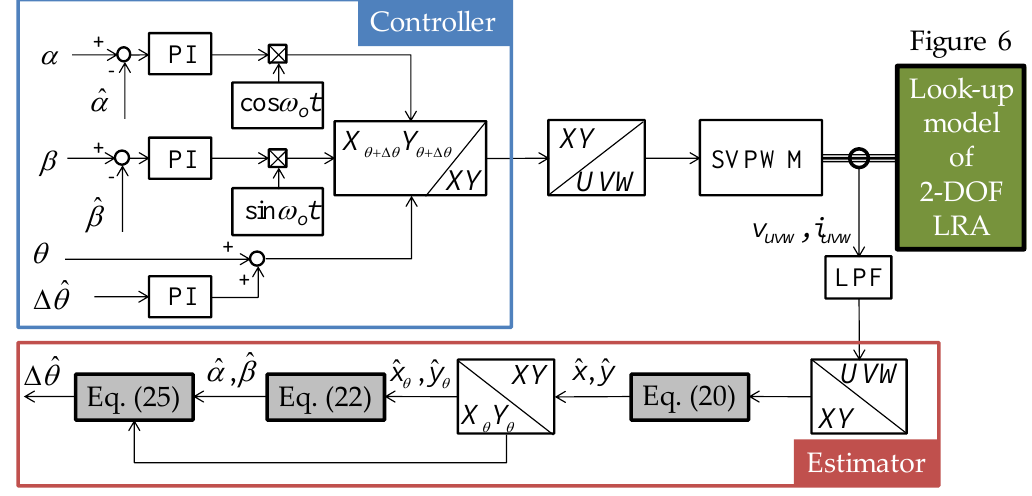
Figure 11. Overall control and estimation block diagram of the proposed 2-DOF LRA